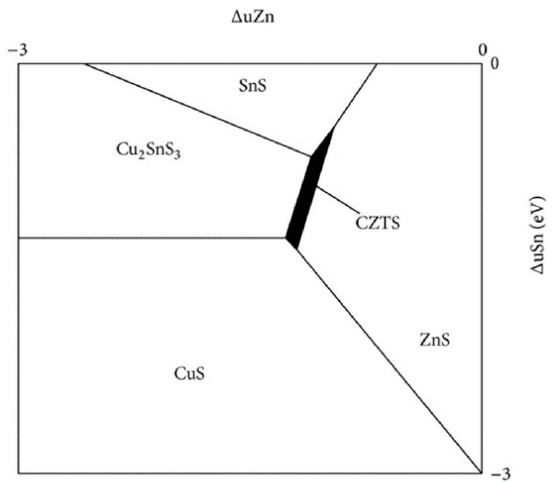
Figure 1. Chemical potential phase diagram of CZTS under Cu-rich conditions [26].